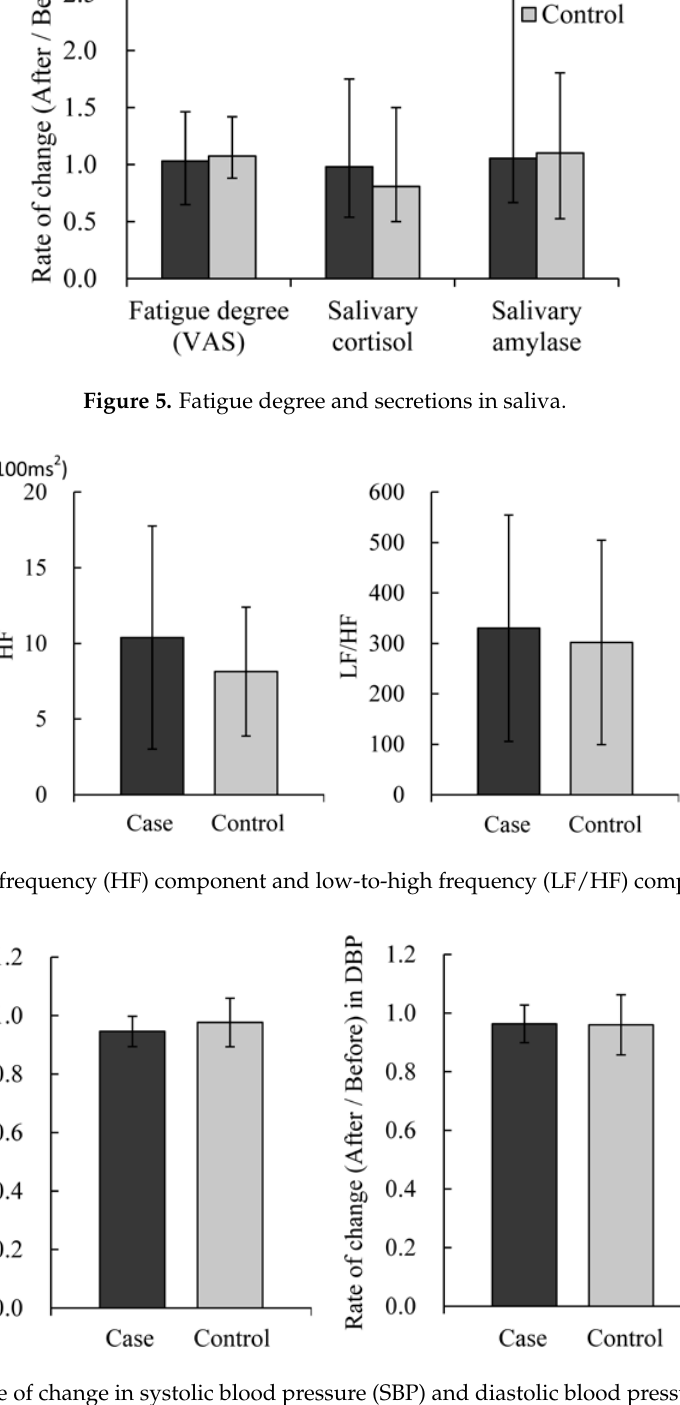
Figure 7. Rate of change in systolic blood pressure (SBP) and diastolic blood pressure (DBP).